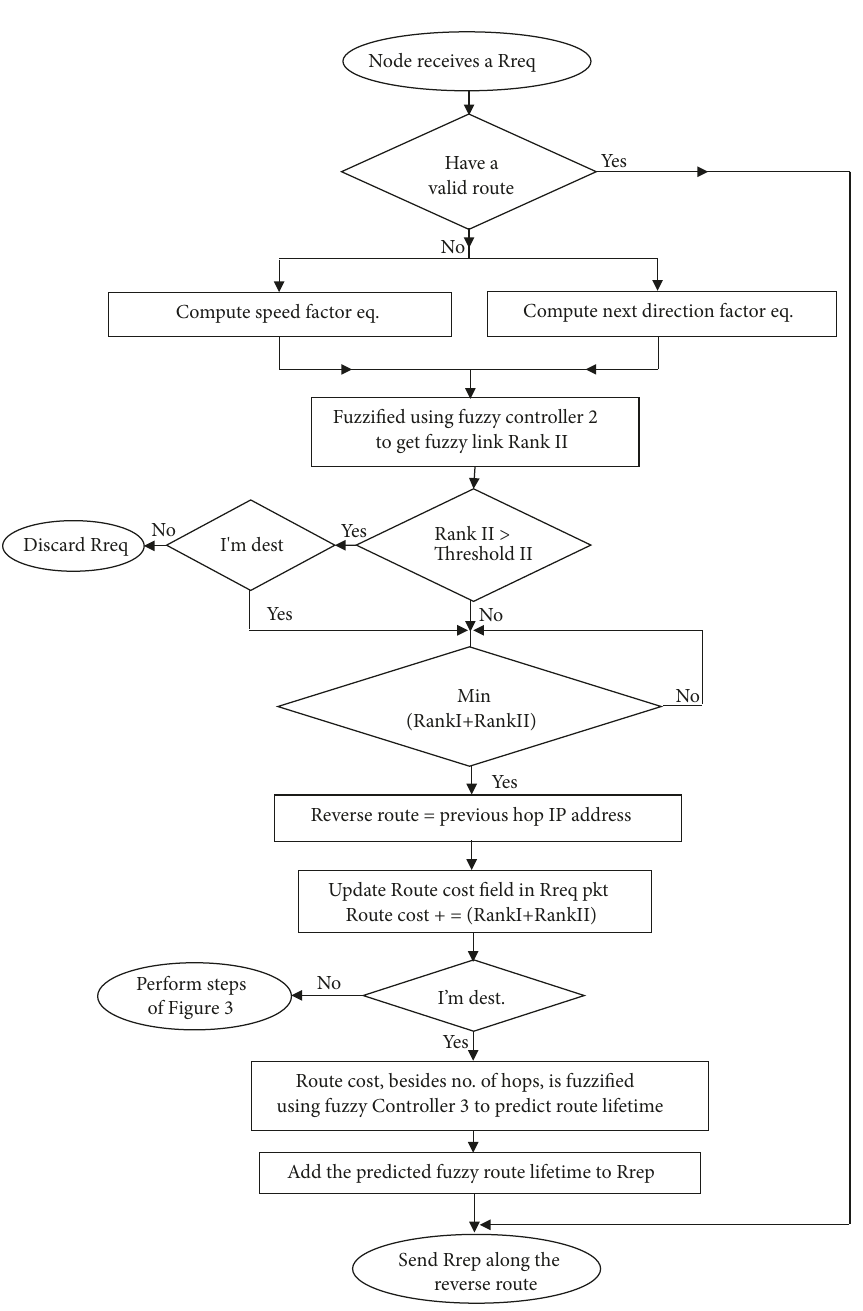
Figure 4: Additional steps of OFAODV upon RREQ